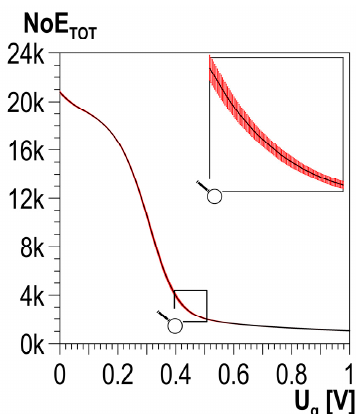
Figure 5. Averaged distribution of the total number of events ( NoE TOT ) with standard deviation values (marked in red).